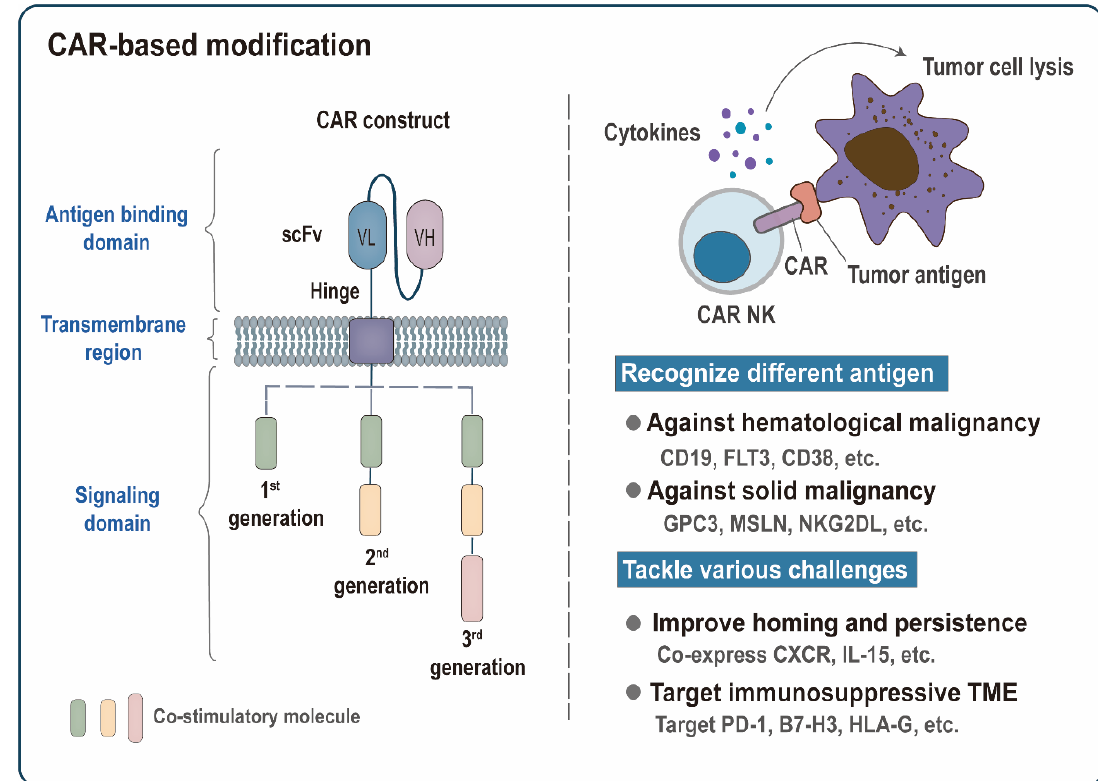
Figure 3. Chimeric antigen receptors (CAR)-based modification. Functional CAR molecule often consists of an antigen-binding domain, a transmembrane region, and an intracellular signaling domain. The extracellular domain contains a single-chain variable fragment (scFv) that binds to tumor antigens. Conventional CAR receptors are divided into three generations. Based on the structure of the first-generation CAR, the second and third-generation CARs with enhanced proliferation and killing capability are formed by adding the intracellular part of one or two costimulatory molecules. CAR molecules confer NK cells the ability to recognize tumor antigens specifically and transmit activation signals into NK cells, thereby triggering the lysis of tumor cells. The development of CAR modification has two main focal points: recognizing different tumor antigens and tackling various challenges. The scFv structures targeting different tumor antigens endow CAK-NK cells with different specificities against multiple malignancies. Co-expression of the chemokine receptors (CXCR) or IL-15 can further promote homing of CAR NK cells to tumor sites or improve their in